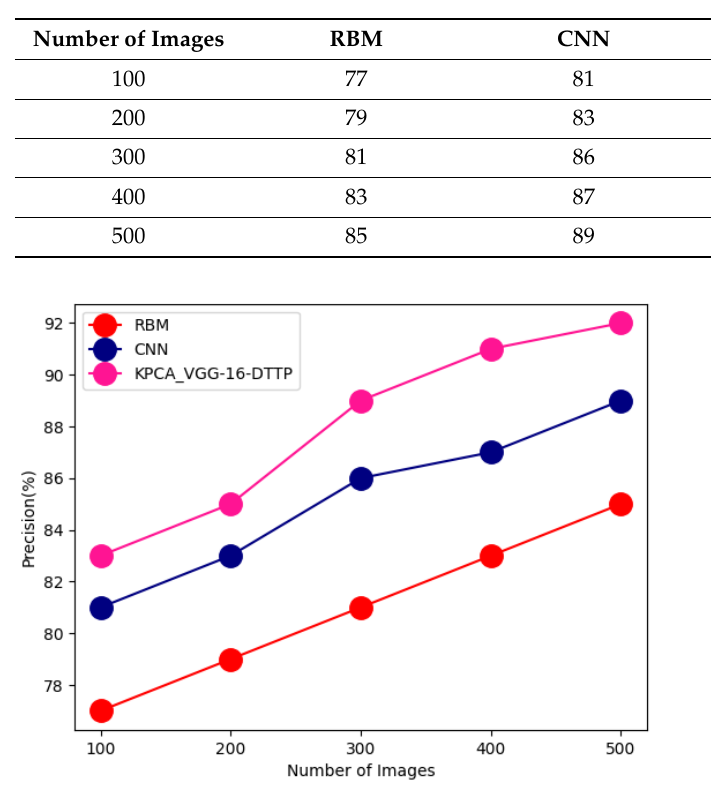
Figure 4. Comparison of Precision.